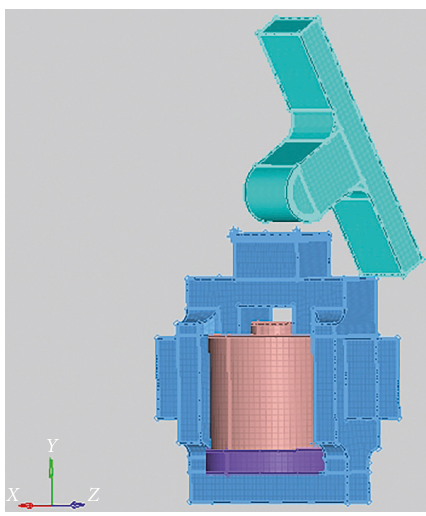
Figure 10: Simplified simulation model of the rigid body overload verification experiment. Table 1: Material property parameters of 65 Mn and 2A12